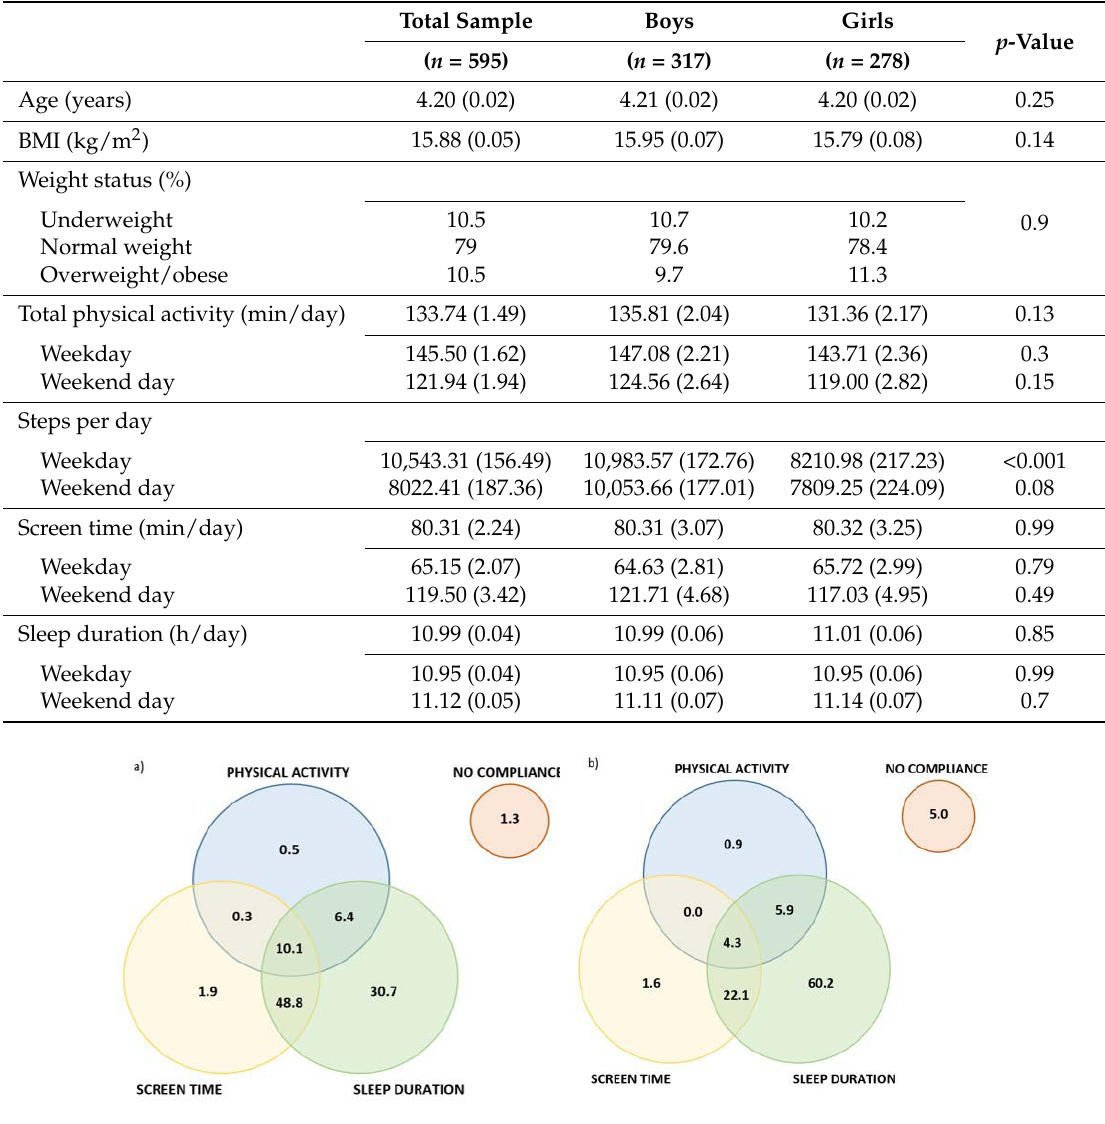
Table 1. Descriptive characteristics of the sample.